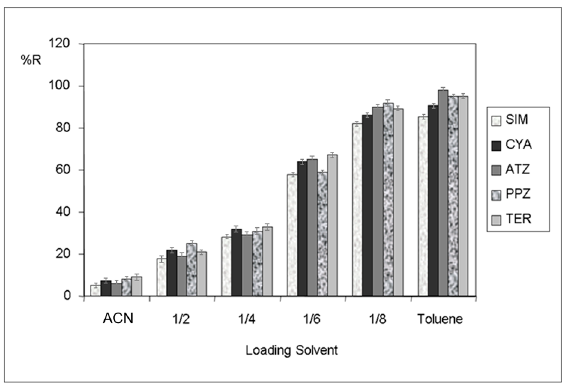
Figure 2. Mean recoveries (%R for n = 3) obtained for the optimization of the retention of the different triazines in the MIP fibre.